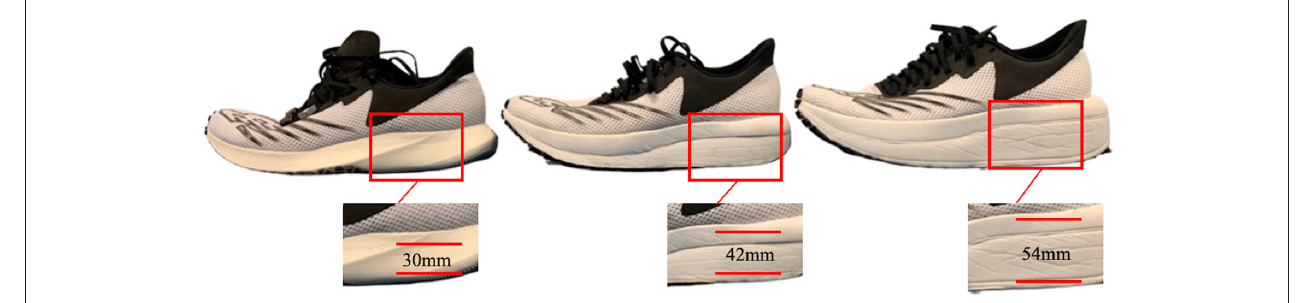
FIGURE 1 | Three shoe models were tested in this study. From left to right, MT was 30, 42, and 54mm,